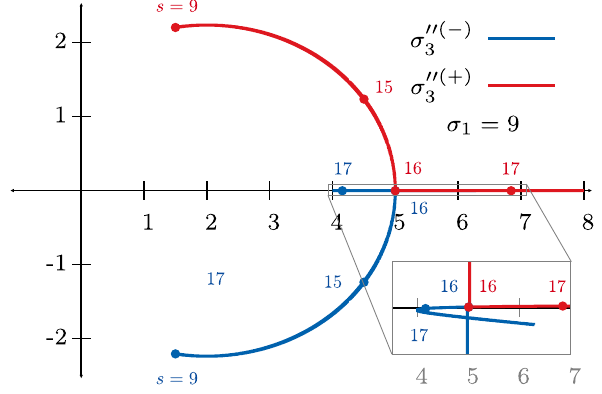
Fig. 13 The triangle diagram T B contribution to the kernel K 11 . We take the isobar to have a narrow width with mass M . For numerical evaluations, m 1 = m 3 = μ 31 = 1